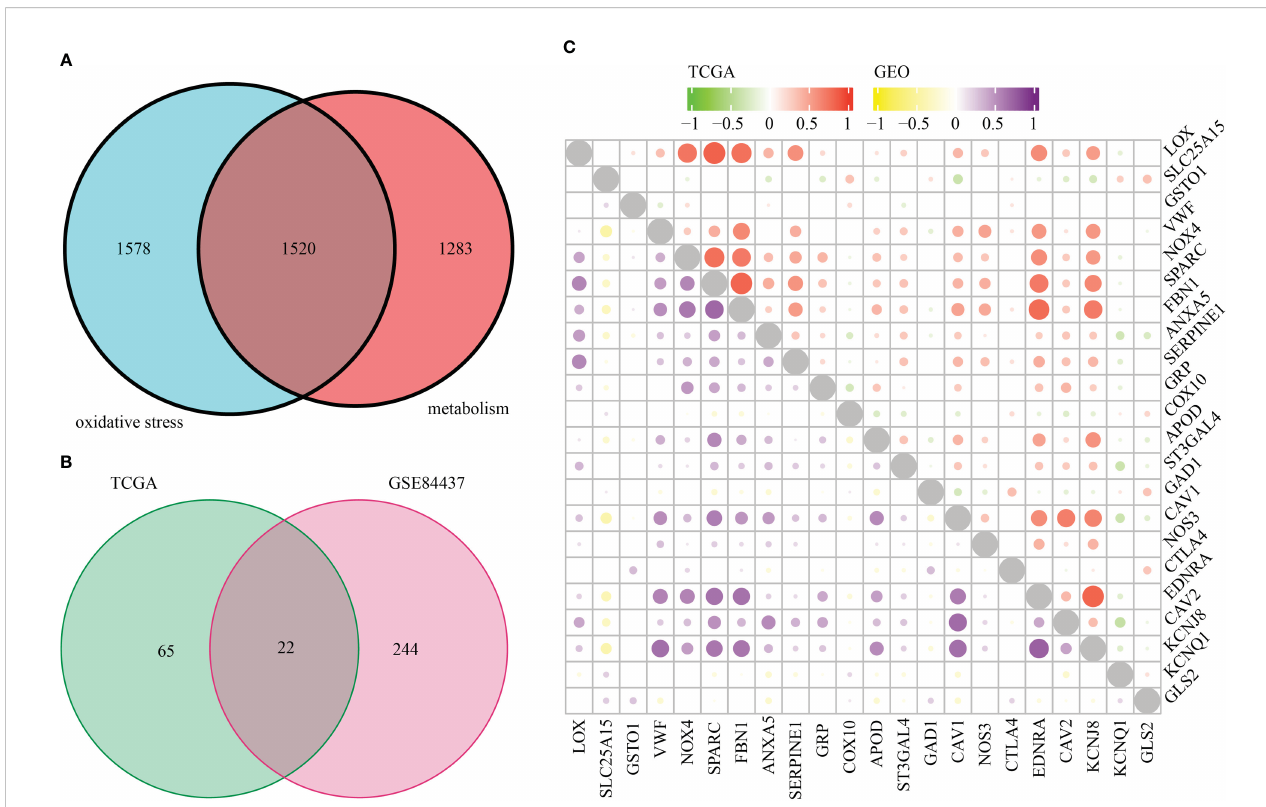
FIGURE 2 22 oxidative metabolism-related genes (OMRGs) with prognostic signi fi cance were obtained for subsequent analysis. (A) Venn diagram to fi nd 1520 OMRGs. (B) Venn diagram depicting 22 prognostic OMRGs in both TCGA and GEO datasets. (C) The plot shows the result of co-expression relationships of 22 OMRGs in STAD. The size of the dot re fl ects the value of the